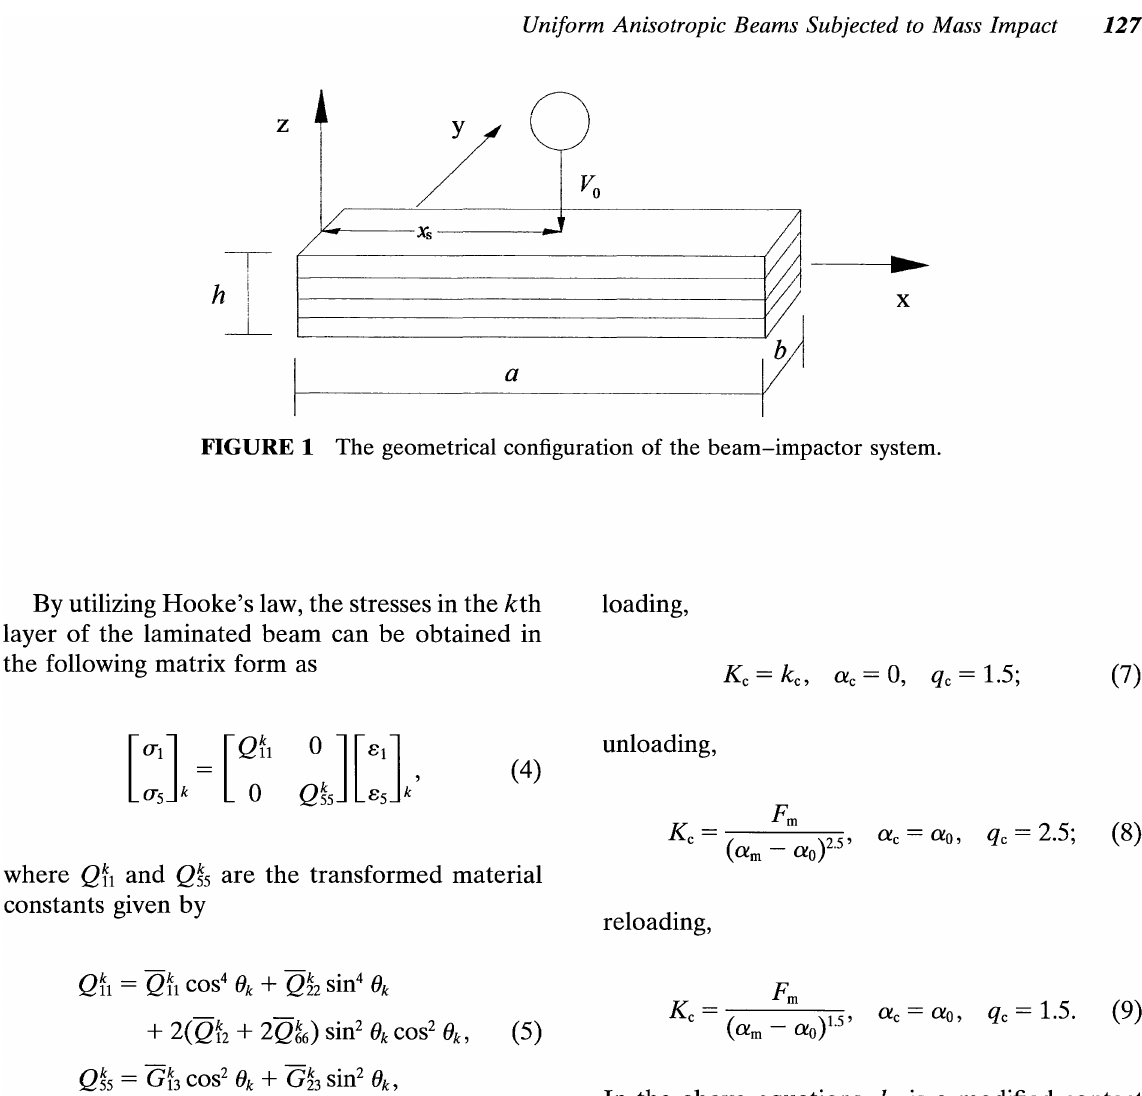
FIGURE 1 The geometrical configuration of the beam-impactor